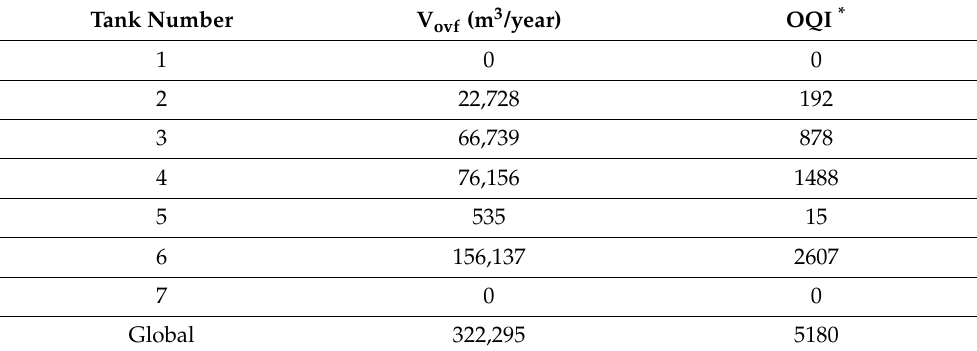
Figure 12. Best and average fitness evolution in control strategy #2 when minimizing OQI. Table 10. Simulation results when the overflow quality index is minimized (strategy #2).